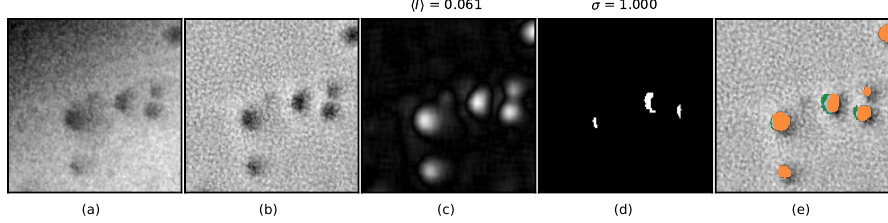
Figure 6. Results for the mid-contrast real defects test dataset. ( a ) is input, ( b ) is the residual image, residual analysis kernel results are for average kernel in ( c ) and standard deviation in ( d ). Above the patch is the maximum value indicated. Kernels above thresholds are indicated in ( e ) with blue ( (cid:104) I (cid:105) and σ ), green ( σ ), and orange ( (cid:104) I (cid:105) ).